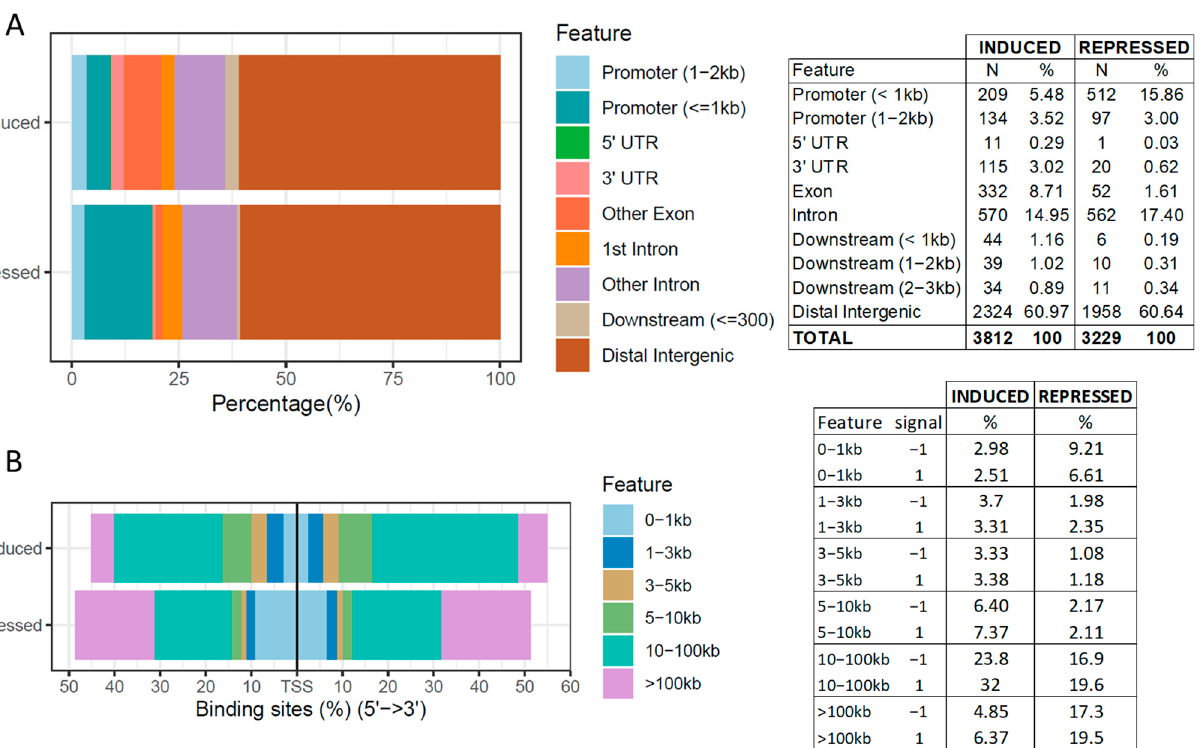
Figure 1. ( A ) Annotation of induced and repressed differentially CTCF-binding sites (DCBS) after weaning. ( B ) Distribution of the induced and repressed DCBS after weaning relative to TSS.